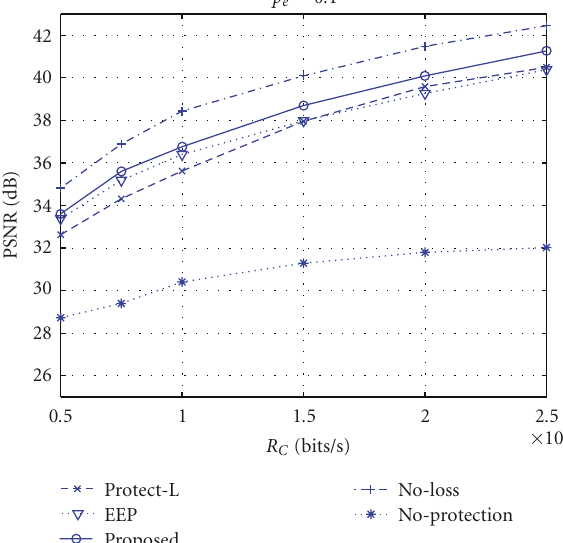
Figure 20: Results for p e = 0 . 10 for “Rena” video.